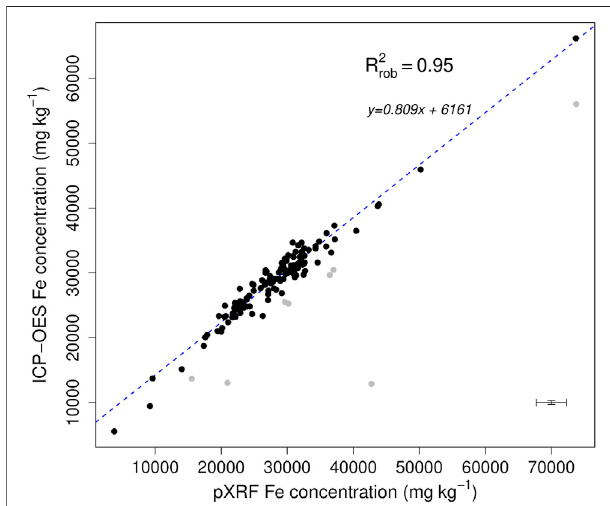
FIGURE 3 | Total Fe concentrations (mg kg − 1 ) measured by the inductively coupled plasma optical-emission spectrometry (ICP-OES) method as a function of those measured by the portable X-ray fl uorescence (pXRF) methodontheYedomadomaindeposits.Errorsbars( ± 2 σ )arebasedon three repetitions of three samples for the ICP-OES method and fi ve or three repetitions of twenty samples for the pXRF method. The robust linear regression is presented (blue line; alpha (cid:1) 0.95; n (cid:1) 144), excluding the grey points, and the equation is provided.